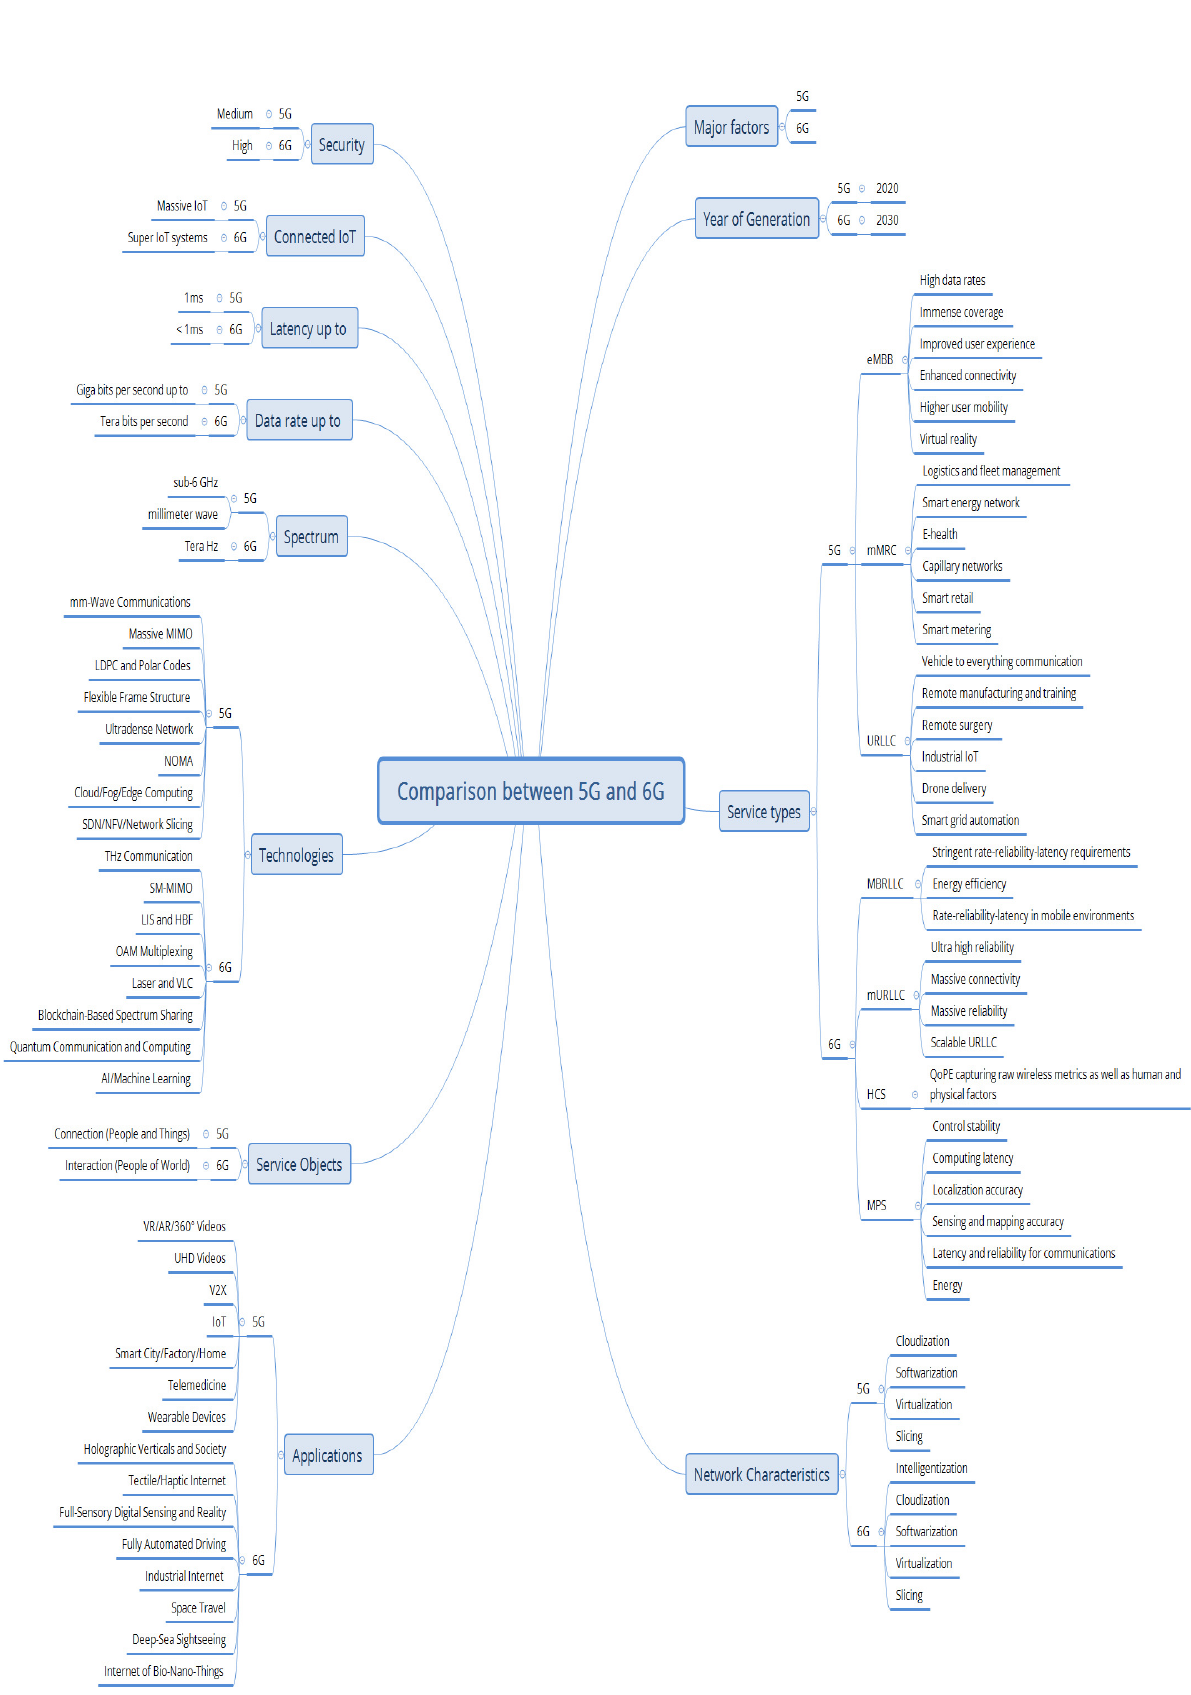
Figure 5. Comparison between 5G and 6G. Service Classes, Their Performance Indicators, And Example